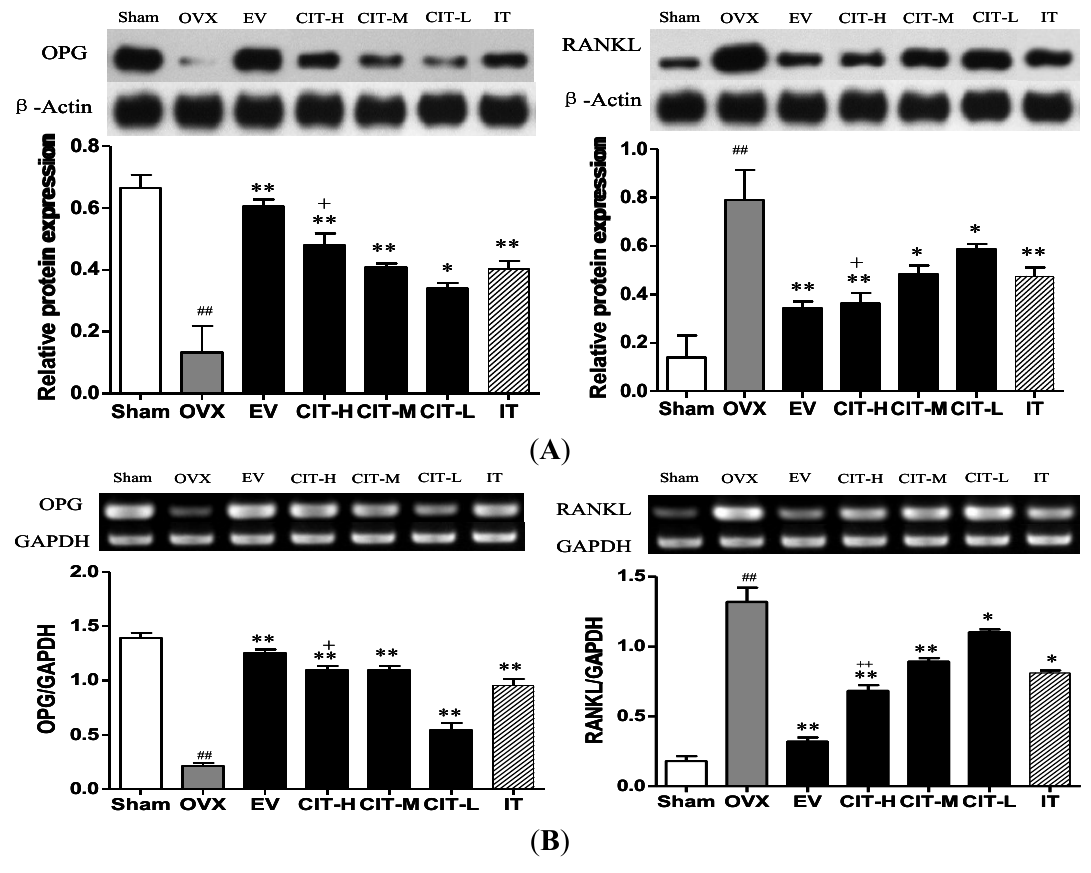
Figure 6. Related proteins and genes expressions in osteoporotic rats femur. ( A ) OPG and RANKL protein expressions in femur of OVX rats. Effects of 12-week treatment with EV, CIT and IT on protein expressions of osteoprotegerin (OPG) and receptor activator of nuclear factor kappa-B ligand (RANKL); ( B ) OPG and RANKL mRNA expressions in femur of OVX rats treated with EV, CIT and IT for 12 weeks. Total RNA was isolated and RT-PCR was performed to determine OPG and RANKL mRNA expressions. Values are expressed as means ± SD ( n = 8); ## p < 0.01 compared with sham, * p < 0.05, ** p < 0.01 compared with OVX, + p < 0.05, ++ p < 0.01 compared with IT